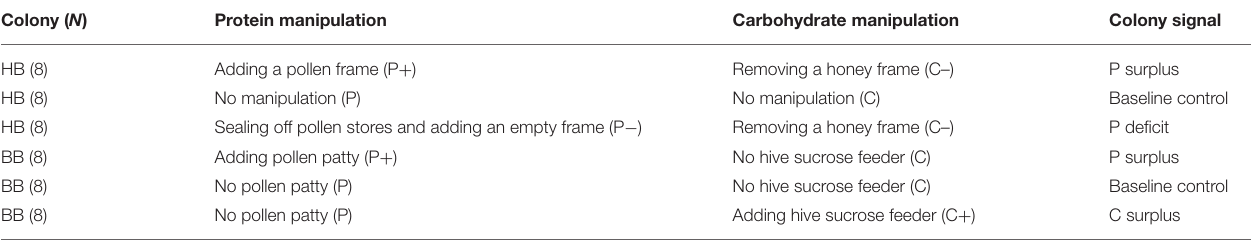
TABLE 1 | Experimental manipulations applied to colonies. Colony ( N ) Protein manipulation Carbohydrate manipulation Colony